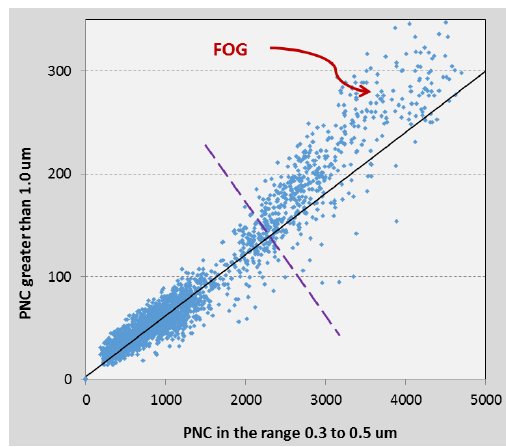
Figure 5. Graph of PNC>1.0µm against the PNC between 0.3– 0.5µm during a day that included a period of fog (31 July). The straight line represents the best fit through the points under the bro- ken line